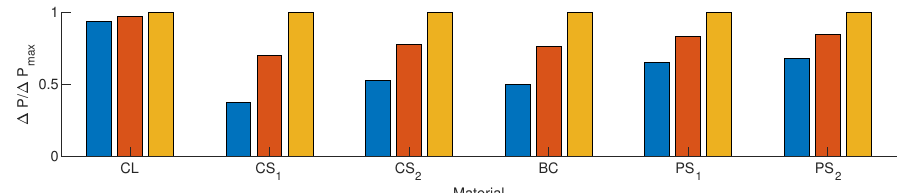
Figure 11. Normalized pressure drop as a function of water flow for an air velocity of 1 m s − 1 . The colour bars correspond to different water flows: blue: Q = 2 L min − 1 m − 1 , red: Q = 6.2 L min − 1 m − 1 and orange: Q = 10 L min − 1 m − 1